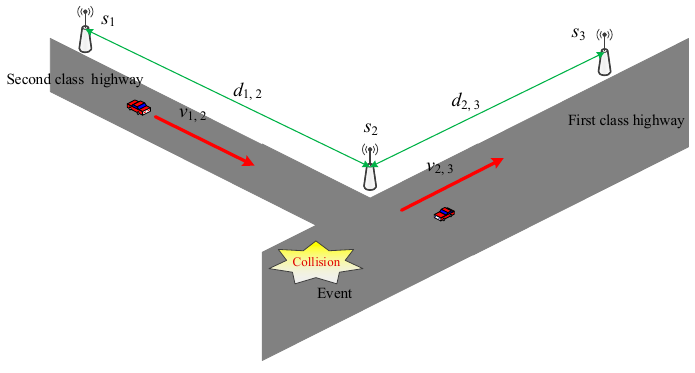
Figure 3. Traffic prediction based on VWC.